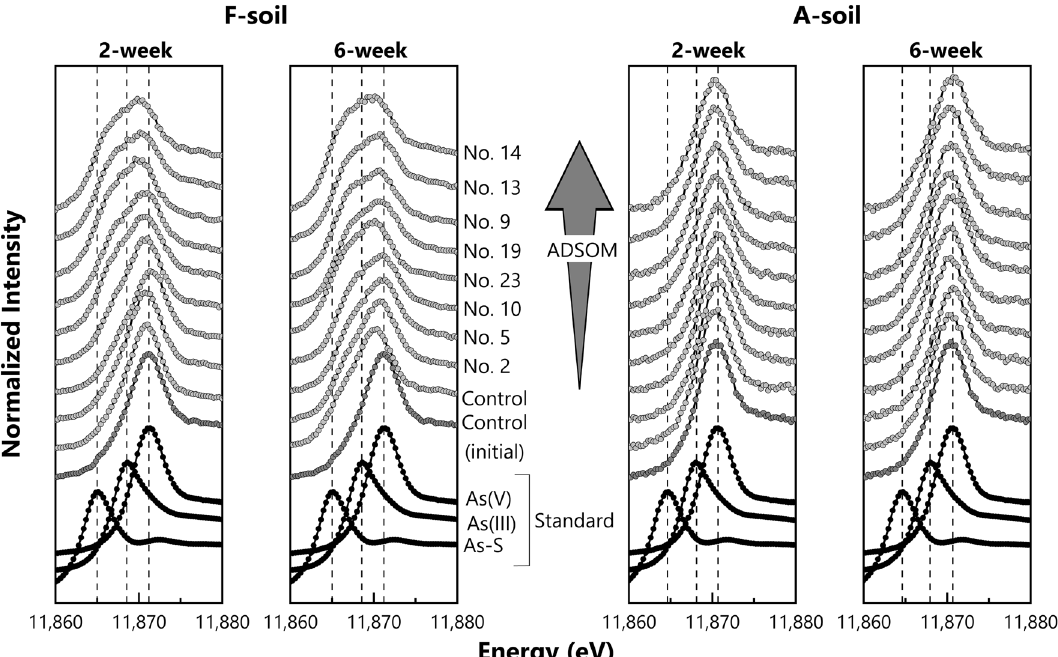
Figure 5. Arsenic K-edge X-ray absorption near edge structure spectra of solid phases in F-soils and A-soils, with or without selected organic amendments. The samples were collected after the 2- and 6-week incubations. Black plots denote the spectra of the reference materials, namely arsenate adsorbed on ferrihydrite [As(V)], sodium arsenite [As(III)], and orpiment (As-S). The spectrum of the initial control soil is shown as a dark gray line in all subfigures for